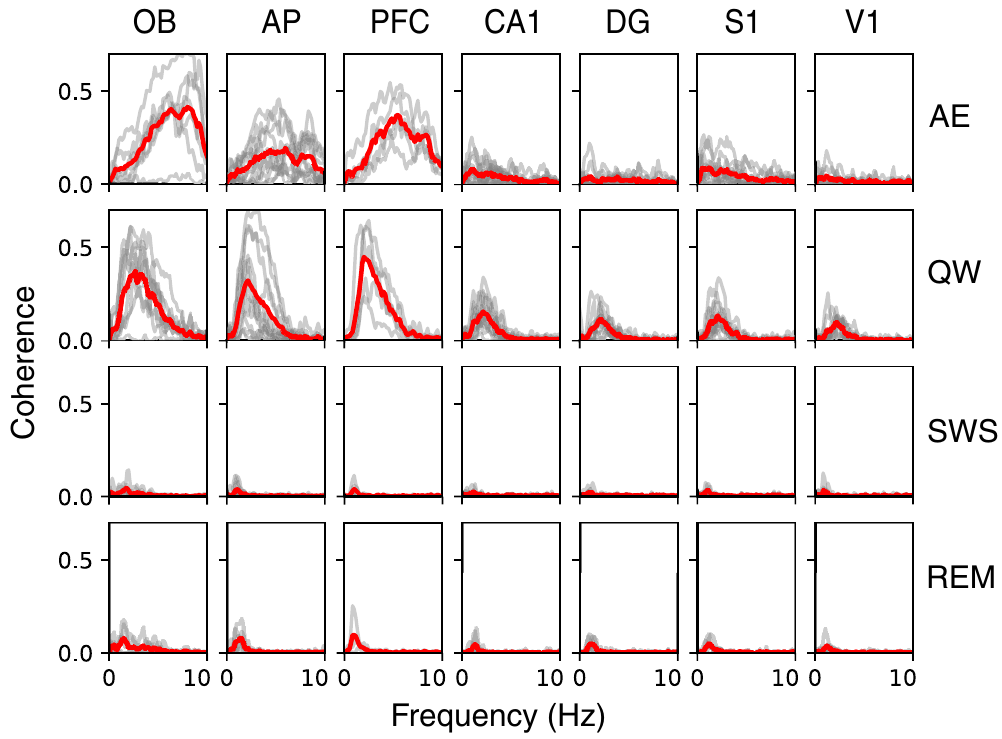
Figure 4. Coherence spectra between LFP and Respiratory signals during the four brain states (AE active exploration, QW quiet waking, SWS slow-wave sleep, REM rapid eye movements sleep), in all structures, in the 0.5–10 Hz range. Results obtained from simultaneous recordings in each rat (grey lines) and averaged across animals (red lines). See sample size (number of rats) in Table 1 and p values in Supplementary Table